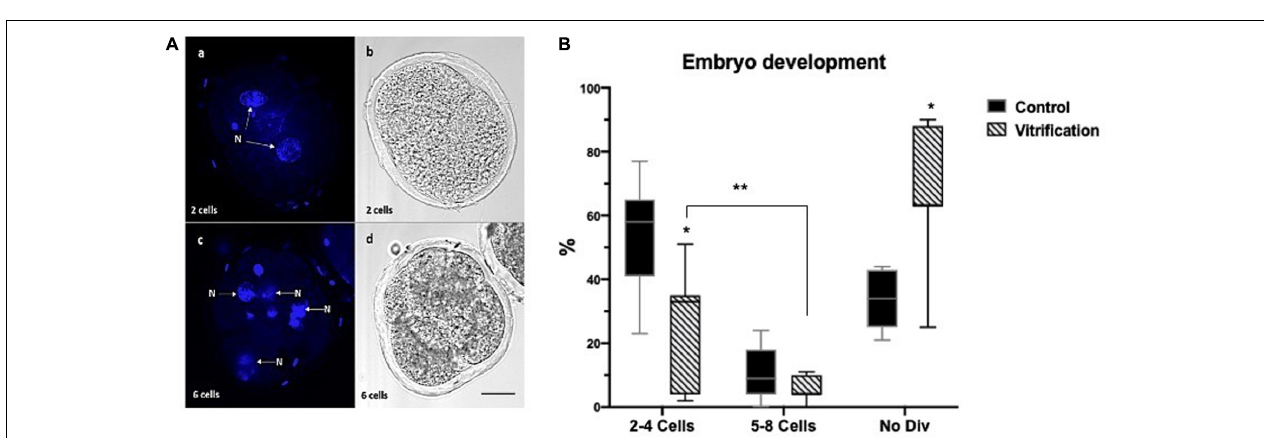
FIGURE 4 | Early embryo development (ED) evaluation by Hoechst staining in the control and vitrified groups. (A) Representative images for early ED evaluation criteria; (a,c) blastomeres stained with Hoechst; (b,d) clear field showing embryos blastomeres; (N) nucleus; the total numbers of evaluated cells in the control and vitrification groups were 241 and 151, respectively; 200 × , scale bar = 30 µ m; (B) percentage of early ED [two to four cells, five to eight cells, and non-divided (No Div)]; *Significant difference vs. control. P < 0.05. **Significant differences between groups. P <